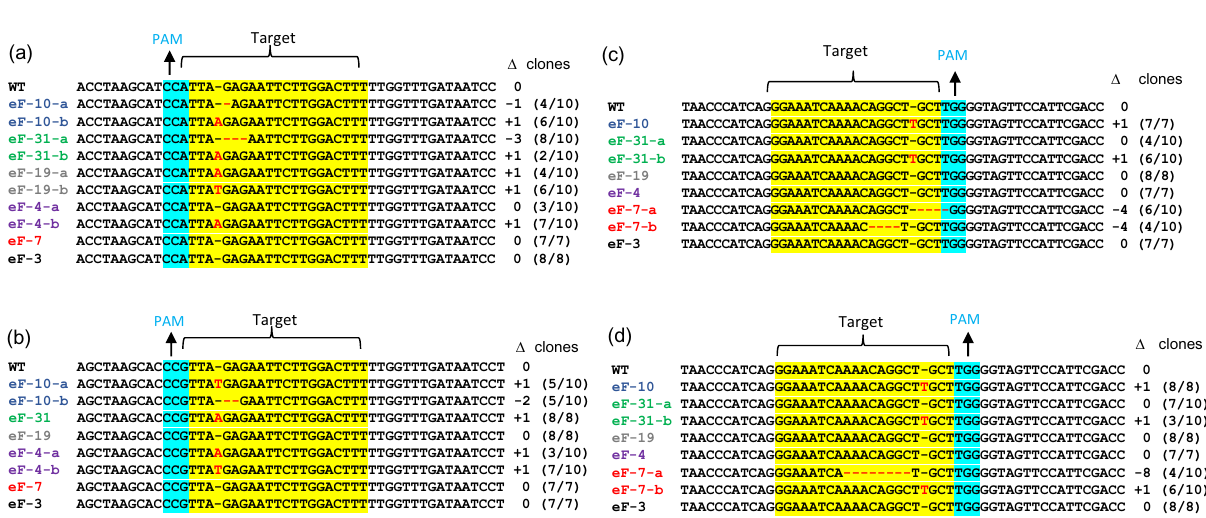
Figure 3. Alignment of eIF4E sequences isolated from the selected T0 lines. ( a ) eIF4E1-S , ( b ) eIF4E1-T , ( c ) eIF4E2-S , ( d ) eIF4E2-T loci. The sgRNA target sequences and the PAM motifs are highlighted in yellow and blue, respectively. Red letters indicate inserted nucleotides. Red dashed lines represent deleted nucleotides. Δ refers to changes in the CRISPR/Cas9 targeted sequence: 0, no change; − deletion; + insertion. “Clones” indicate the number of clones used for